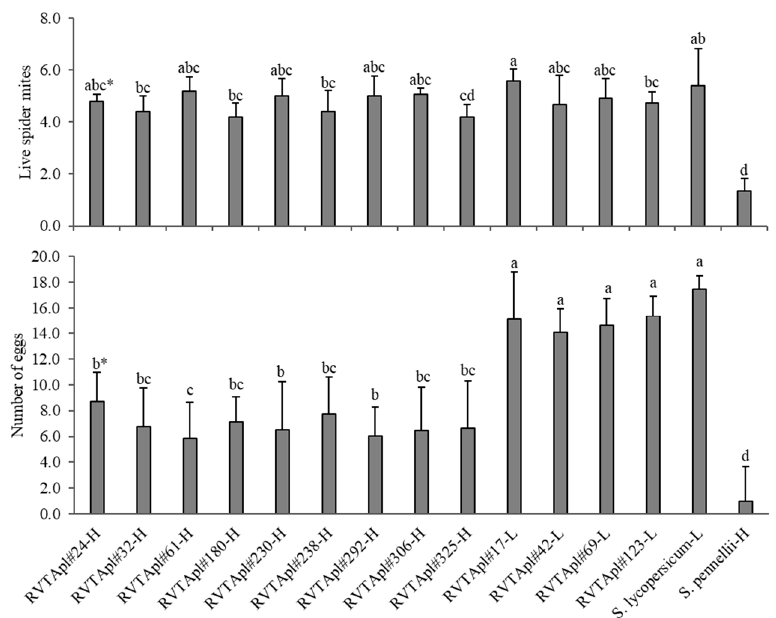
Figure 4. Average number of live mites and eggs in leaf discs of F 2 BC 3 tomato genotypes 24 h after the release of 6 females of Tetranychus urticae . * Averages followed by the same letter do not differ statistically by the Dunn–Bonferroni test, p < 0.05; Kruskal–Wallis number of mites: 70.54 *; number of eggs: 173.19 * ( p < 0.001). Table 6. Correlation between acylsugar content (based on absorbance at 540 nm) and